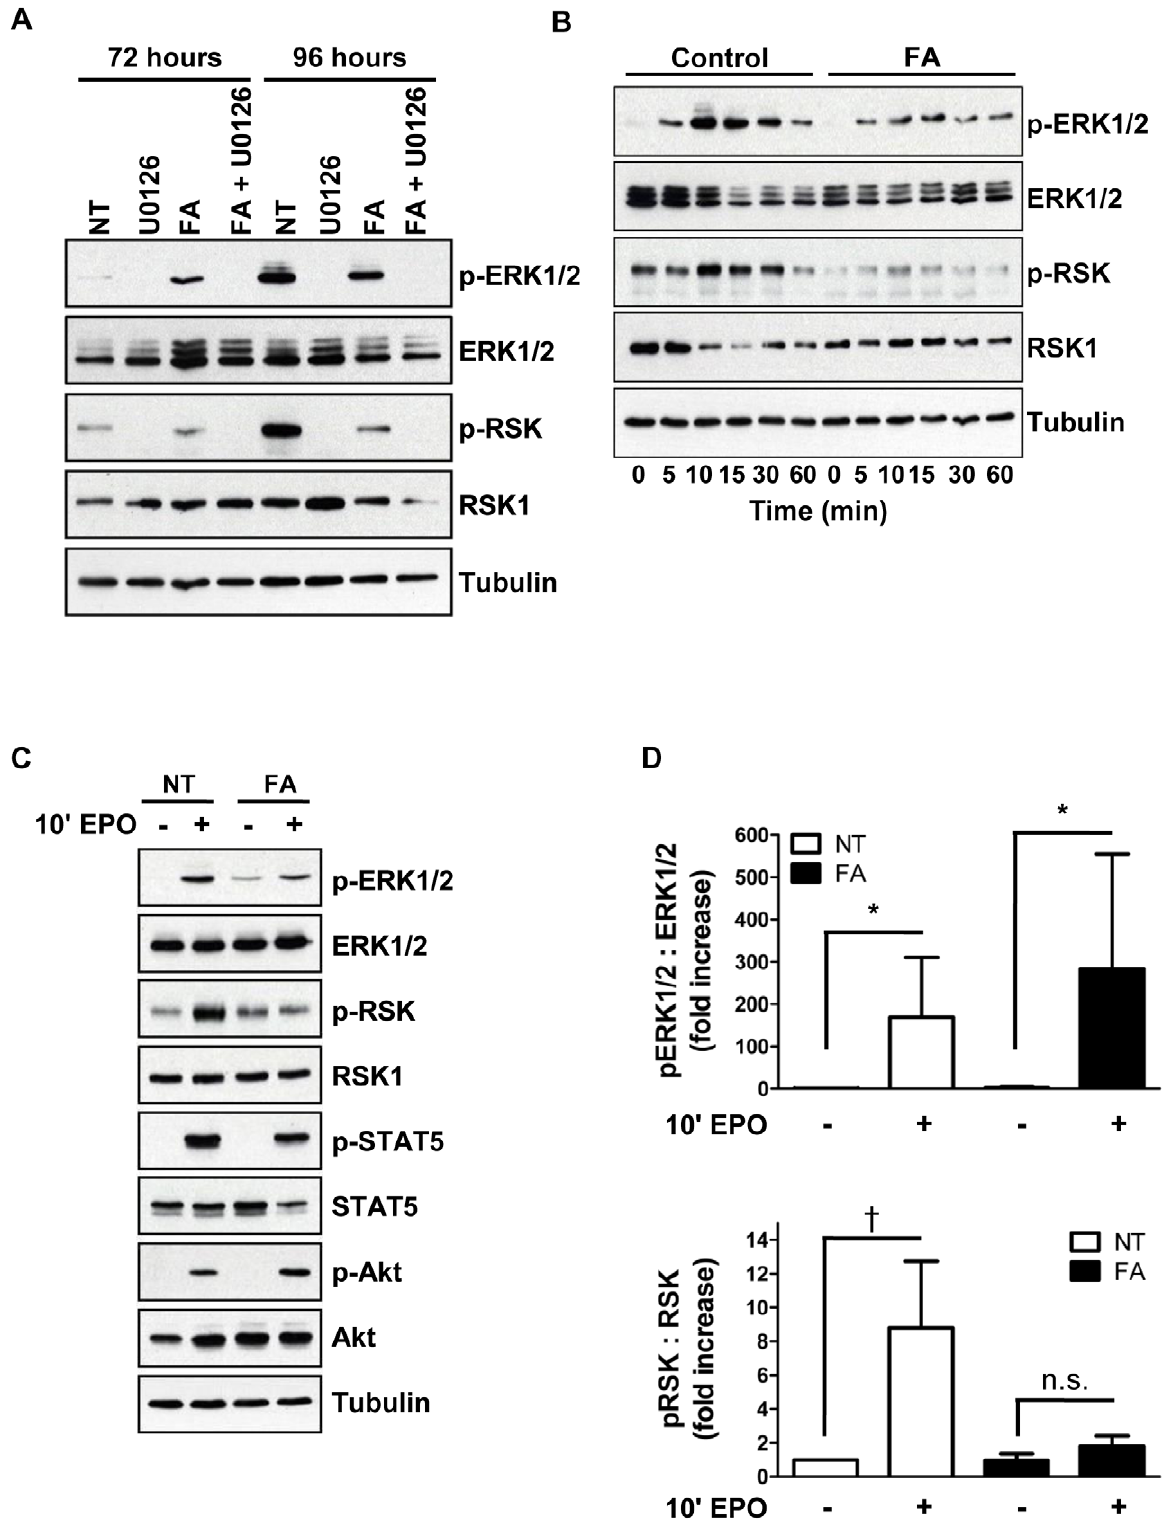
Figure 5. Aconitase inhibition interferes with EPO activation of ERK signaling in a pathway-specific manner. ( A ) Steady state phosphorylation of ERK and RSK as determined by immunoblotting of whole cell lysates of cells from days 3–4 erythroid cultures treated with 50 m M FA and 10 m M U0126 as indicated (NT, untreated). ( B ) Time course of ERK1/2 and RSK phosphorylation. Cells from day 3 erythroid cultures 6 50 m M FA were subjected to 3 hours of cytokine starvation followed by stimulation with 4.5 U/ml EPO for the indicated time periods. ( C ) EPO induction of multiple downstream pathways in cells treated as in panel B . ( D ) Densitometric analysis of pERK1/2:ERK1/2 and pRSK:RSK levels in five independent experiments conducted as in panel C . Presented are mean values 6 SEM for relative phosphoprotein signal divided by total protein signal; * P , 0.05; { P , 0.01; n.s., not significant. doi:10.1371/journal.pone.0023850.g005 PLoS ONE |